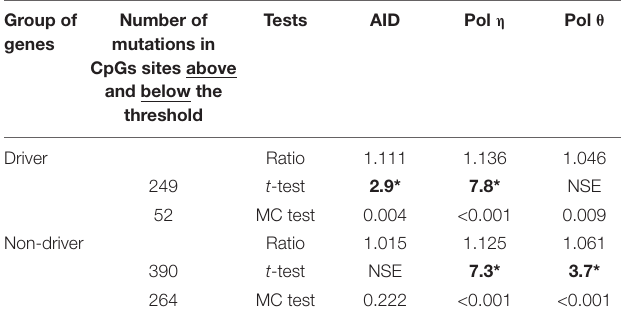
TABLE 4 | Levels of methylation in positions of somatic mutation in CpG sites, the threshold value =